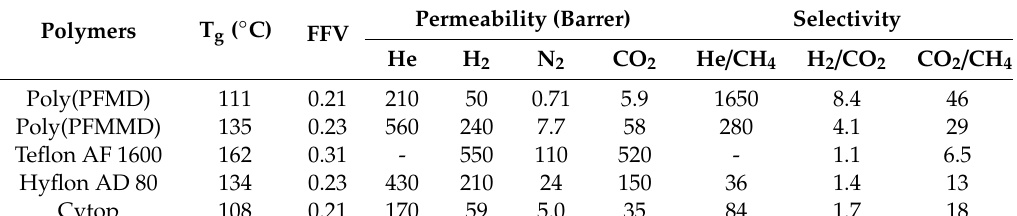
Table 3. Comparison of Physical Properties and Gas Separation Properties (35 °C) of Poly(PFMD),